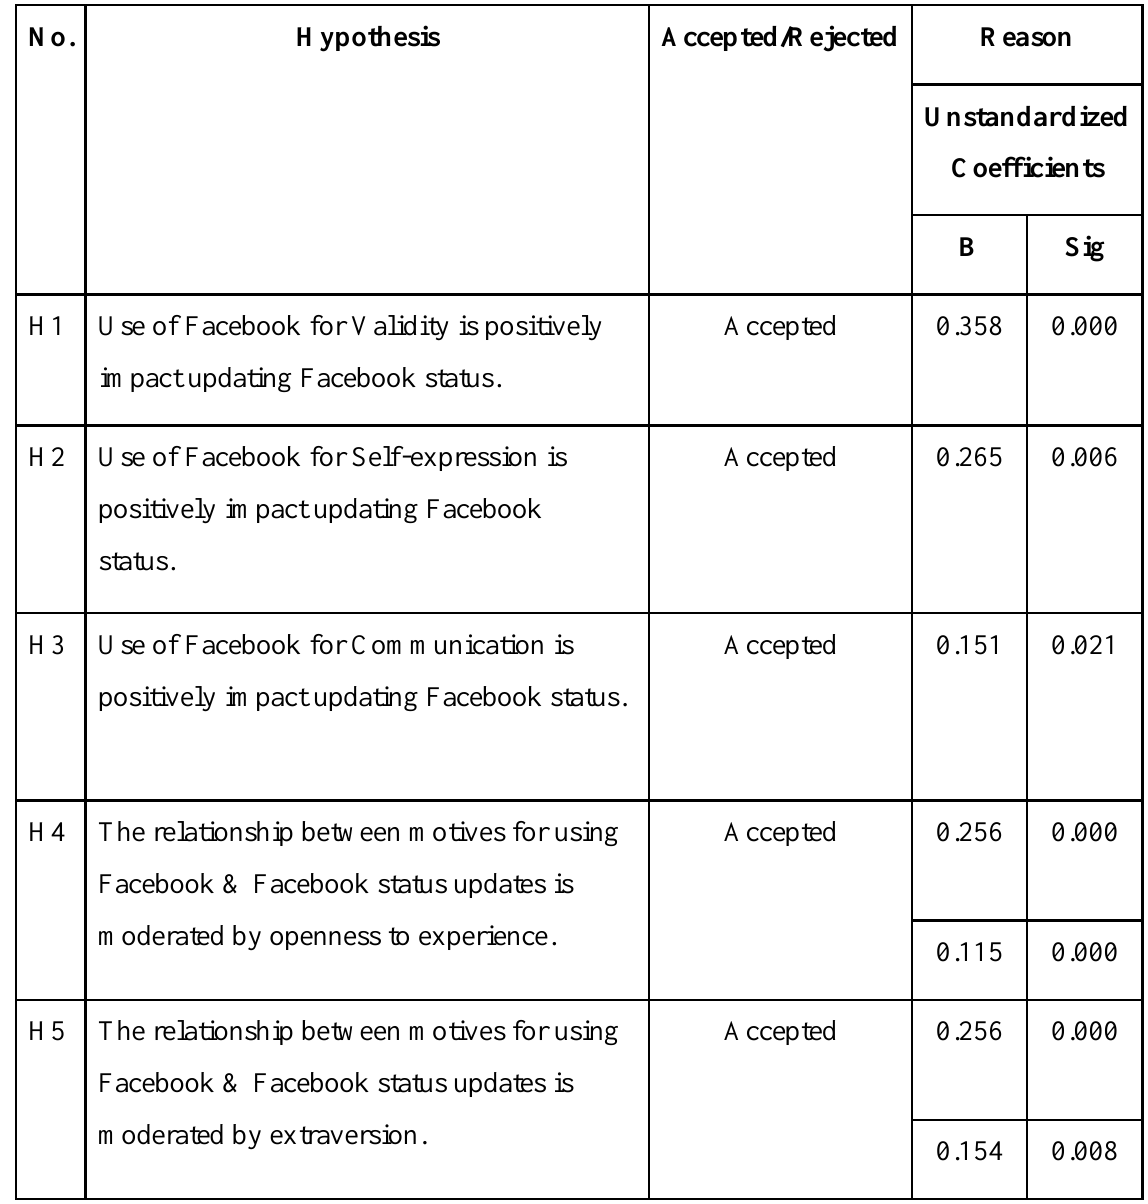
Table 4: Hypothesis